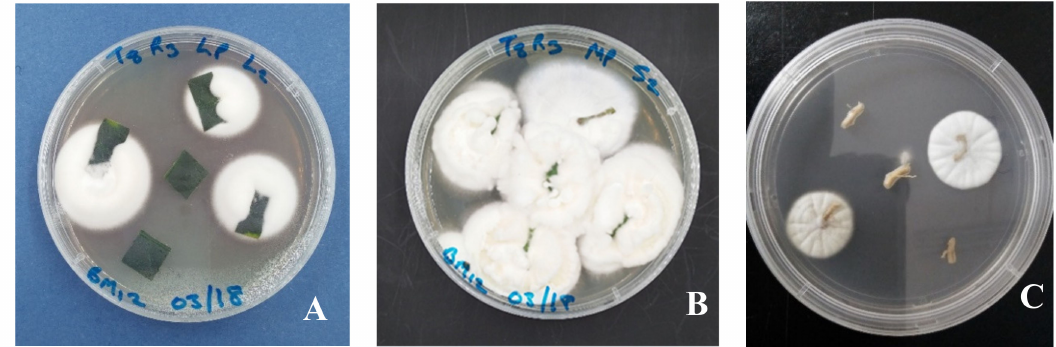
Figure 1. Endophytic Beauveria bassiana (BB Fafu-12) re-isolation from the citrus plant tissues. ( A ) Leaf, ( B ) stem, and ( C ) root tissues following foliar treatment with fungal conidia